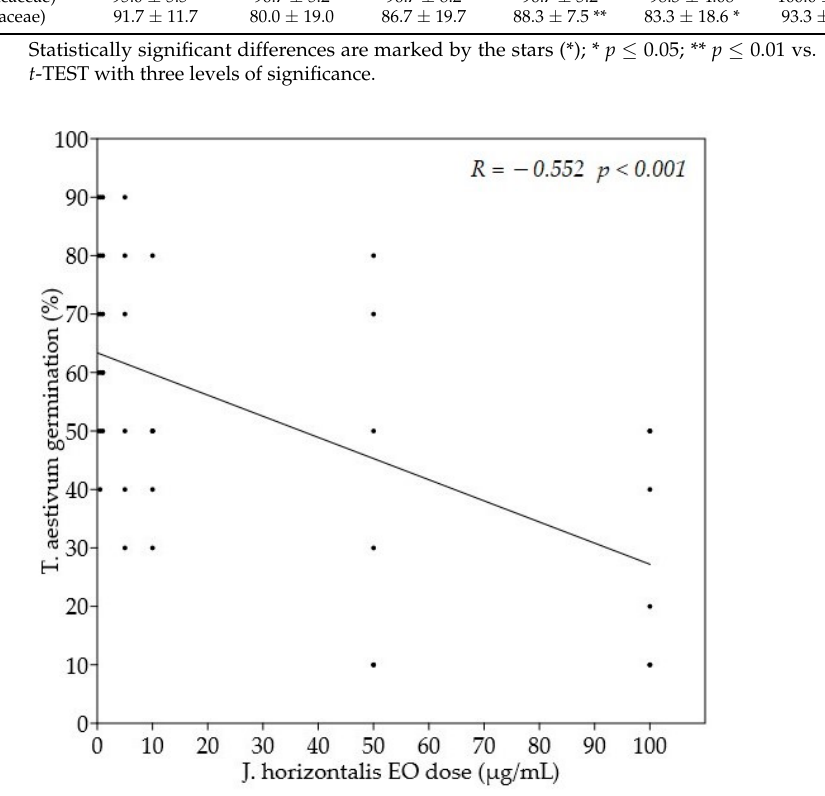
Figure 1. Simple linear regression between J. horizontalis EO dose (µg/mL) and T. aestivum germina- tion (%).